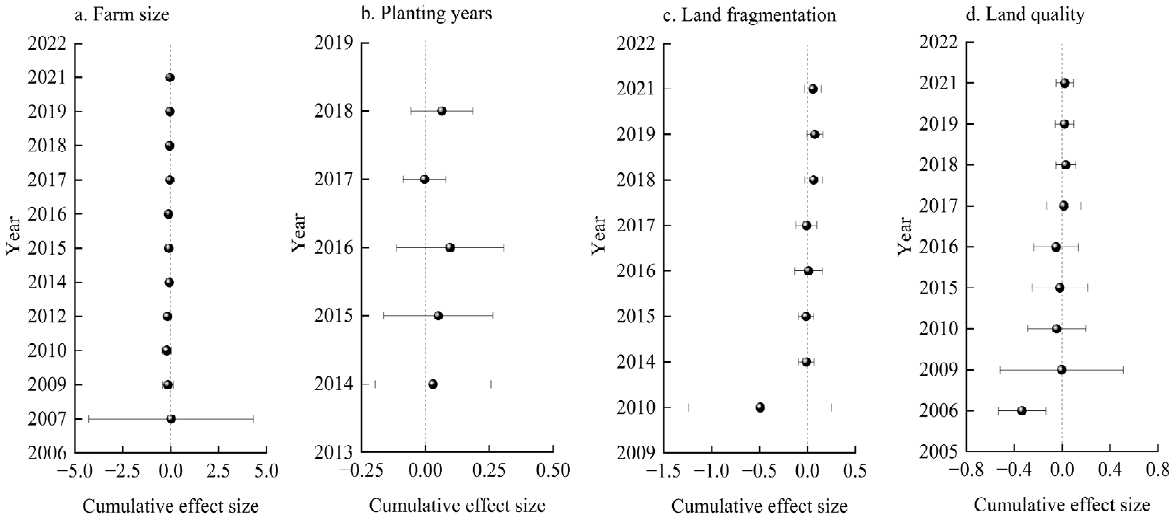
Figure 4. Cumulative meta-analysis trend (planting characteristics).